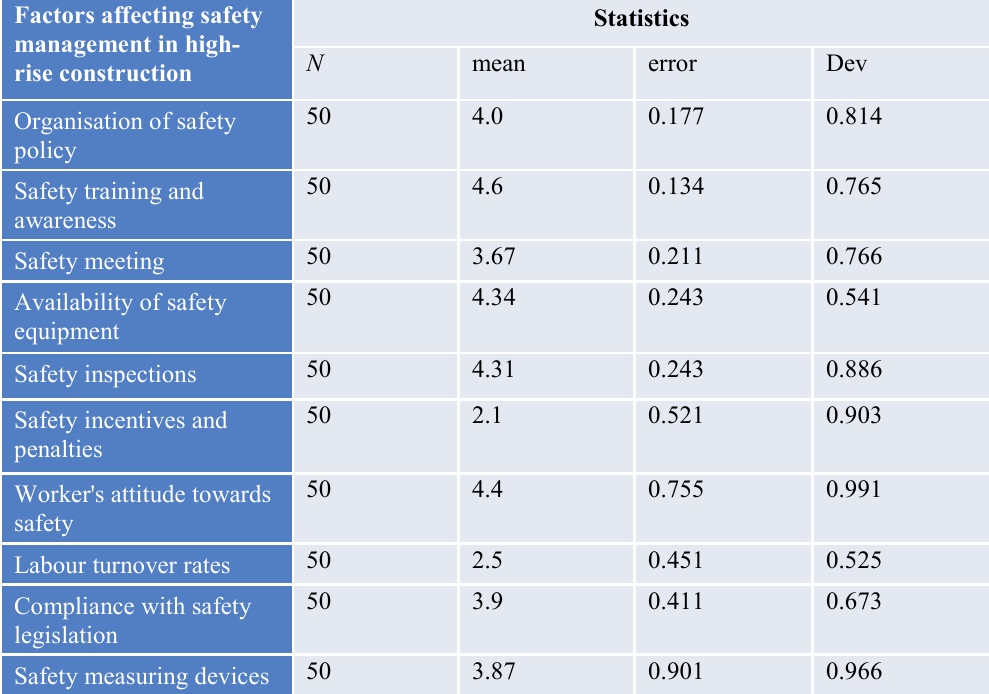
Table 1. Factors Affecting Safety Management in High-Rise Construction in SPSS of IBM Done by Pengcheng Ni (Changzhou,